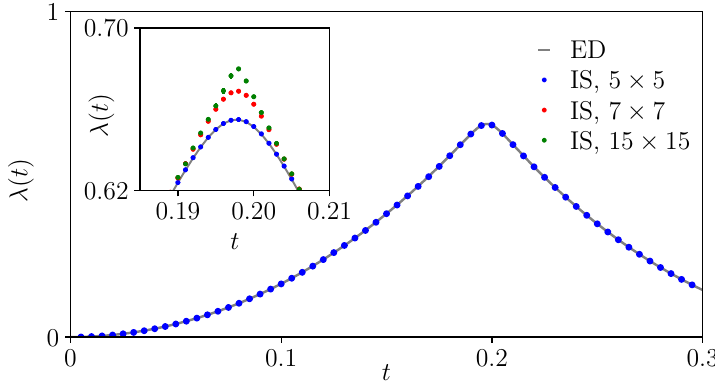
Figure 4: Time evolution of the Loschmidt rate function λ ( t ) corresponding to the return probability (18) for a system initialized in the Γ = h = 0 ferromagnetic ground 〉 and evolved using the Hamiltonian (13) with Γ = 8 J , h = 0. The main state | ψ FM panel shows that the results obtained from the importance sampling (IS) approach (dots) are in good agreement with ED (full line) for a 5 × 5 system. As the system size is increased, the peak in the rate function sharpens, eventually becoming non- analytic in the thermodynamic limit; this is demonstrated in the inset, where we show results for 7 × 7 and 15 × 15 systems for which ED cannot be performed. The numerical results were obtained from 5 × 10 4 , 10 5 and 10 6 independent simulations, in order of increasing system size. The error bars are nearly invisible on the scale of the